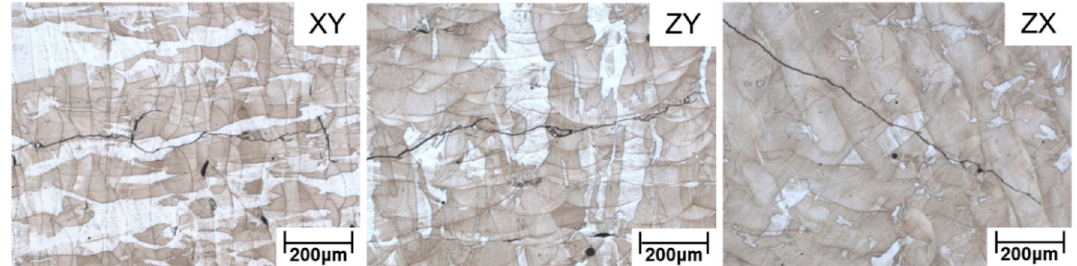
Figure 10. Transcrystalline crack path, regardless of build direction.